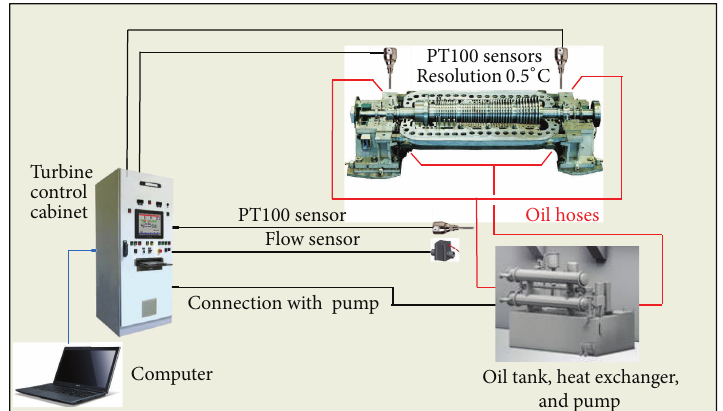
Figure 5: Schematic representation of the experimental